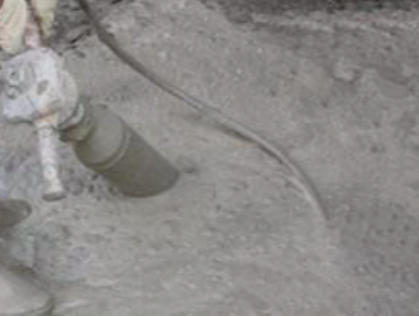
Figure 22: Vibrating.